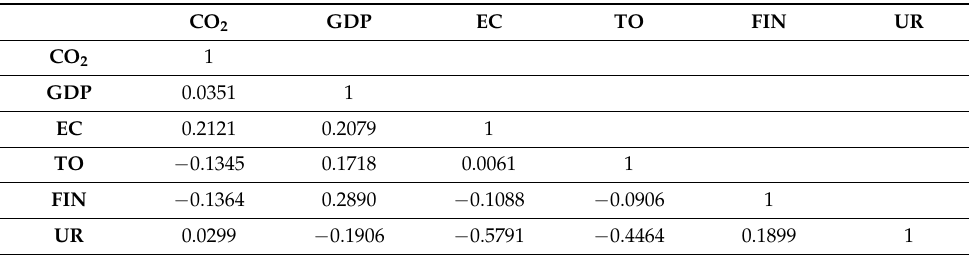
Table 3. Correlation matrix.